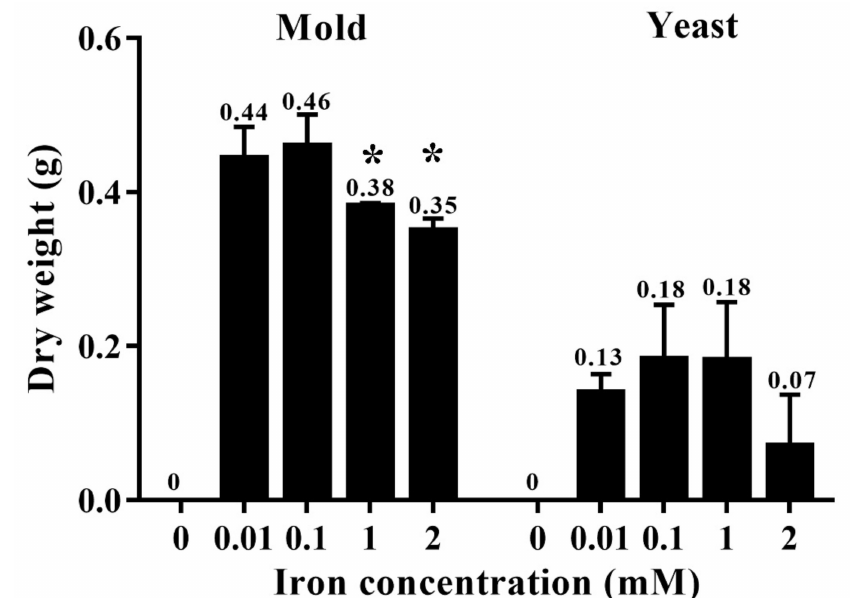
Figure4. Growthof T.marneffei inliquidmediacontainingdifferentironconcentrations. The10 8 conidia / mL of T. marneffei was cultured in 100 mL minimal medium containing 0.00, 0.01, 0.10, 1.00, or 2.00 mM ferric chloride. The bars show average ± SD values from three independent experiments. Numbers above each bar indicate the average value. Asterisks show significant values at p <